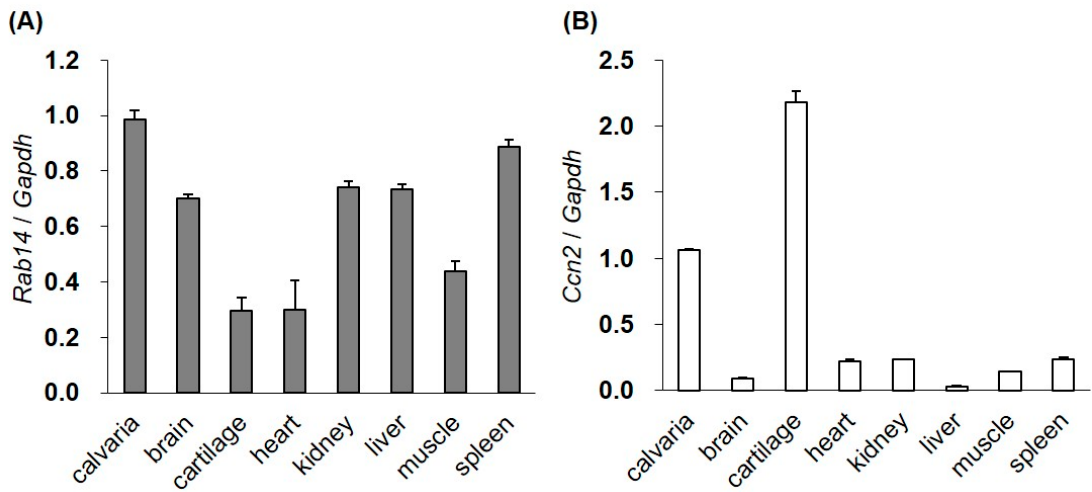
Figure 1. The gene expression of Rab14 and Ccn2 in mouse tissues. The expression of Rab14 ( A ) and Ccn2 ( B ) mRNA in the calvaria, brain, cartilage, heart, kidney, liver, muscle, and spleen tissues of four-day-old mice monitored by qRT-PCR. The level of each mRNA was standardized to that of Gapdh mRNA. The data are presented as the mean ± SD of triplicate samples.